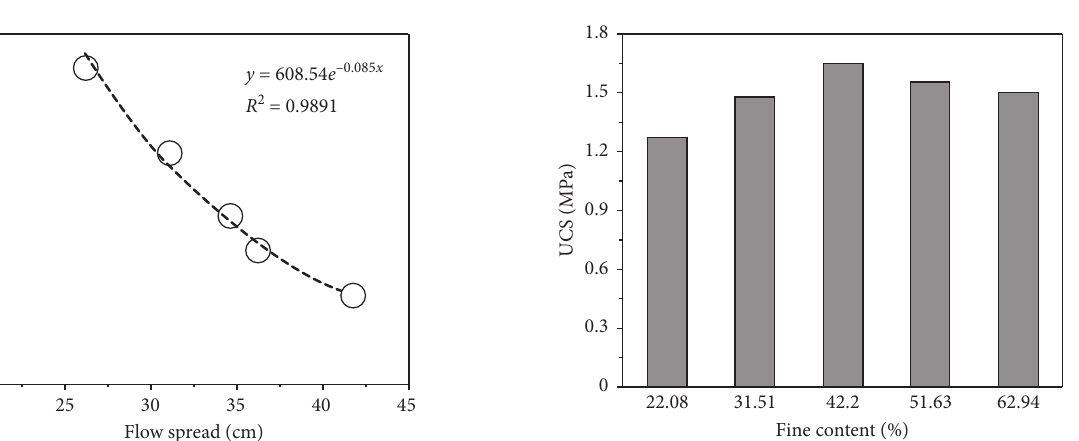
Figure 8: Correlation between flow spread and yield stress for fresh CPB.